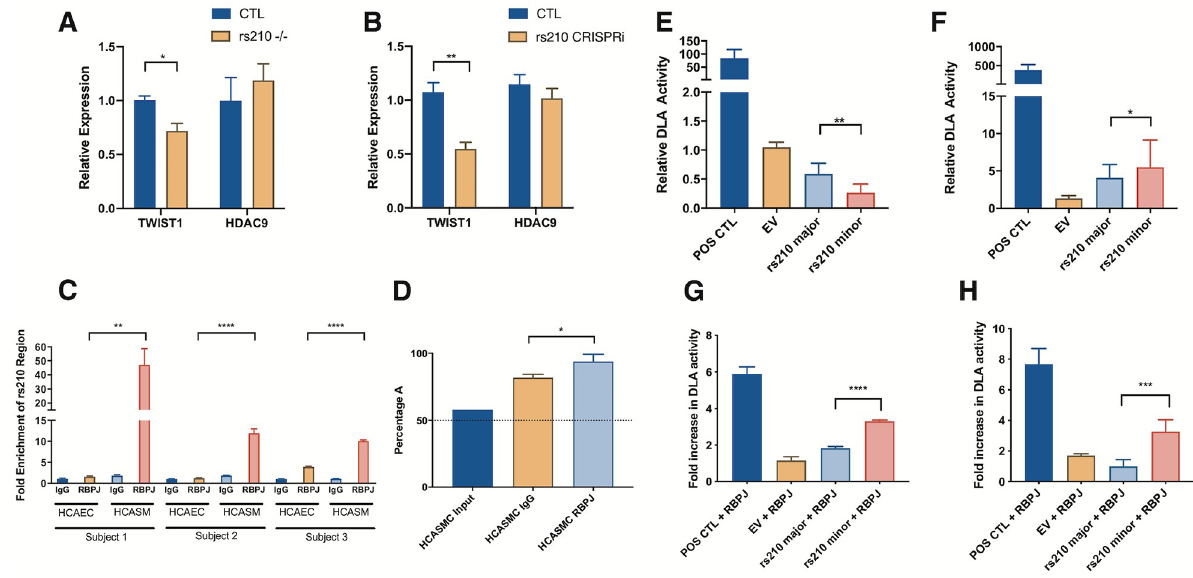
Fig 4. Functional annotation of the rs2107595 region in HEK293T, A7r5, and HCASMCs. � p < 0.05, �� p < 0.01, ��� p < 0.001, ���� p < 0.0001. A) Clonal HEK293T colonies with disruption of rs2107595 locus with CRISPR genome editing show decreased average TWIST1 expression and no significant difference in HDAC9 expression.B) CRISPR inhibition (CRISPRi) targeted to rs2107595 in HCASMCs decreased TWIST1 expression with no significant effect on expression of HDAC9 . A single guide directed to the GWAS lead SNP rs2107595 was cloned into a lentiviral plasmid that encodes dCas9-KRAB and transduced into HCASMC. C) ChIP-qPCR in three separate heterozygous HCAEC and HCASMC lines showed increased binding of RBPJ to rs2107595 locus in HCASMC compared to HCAECs. D) Allele-specific analysis of RBPJ ChIP was performed in three separate heterozygous HCASMCs lines. The averaged results shows preferential pull-down of the minor (A, risk) allele of rs2107595. The dashed line marks the 50 percent allelic balance. E, F) The genomic region around rs2107595 serves a regulatory function in both HEK293 cells (repressor) and in A7r5 SMCs (enhancer) in luciferase reporter assays. In both cases, the minor (risk) allele increases the regulatory function of the region. G,H) When compared with the major allele, the minor allele showed increased luciferase activity in both HEK293 (G) and A7r5 (H) cells in transactivation assays with a constitutively active RBPJ-VP16 fusion